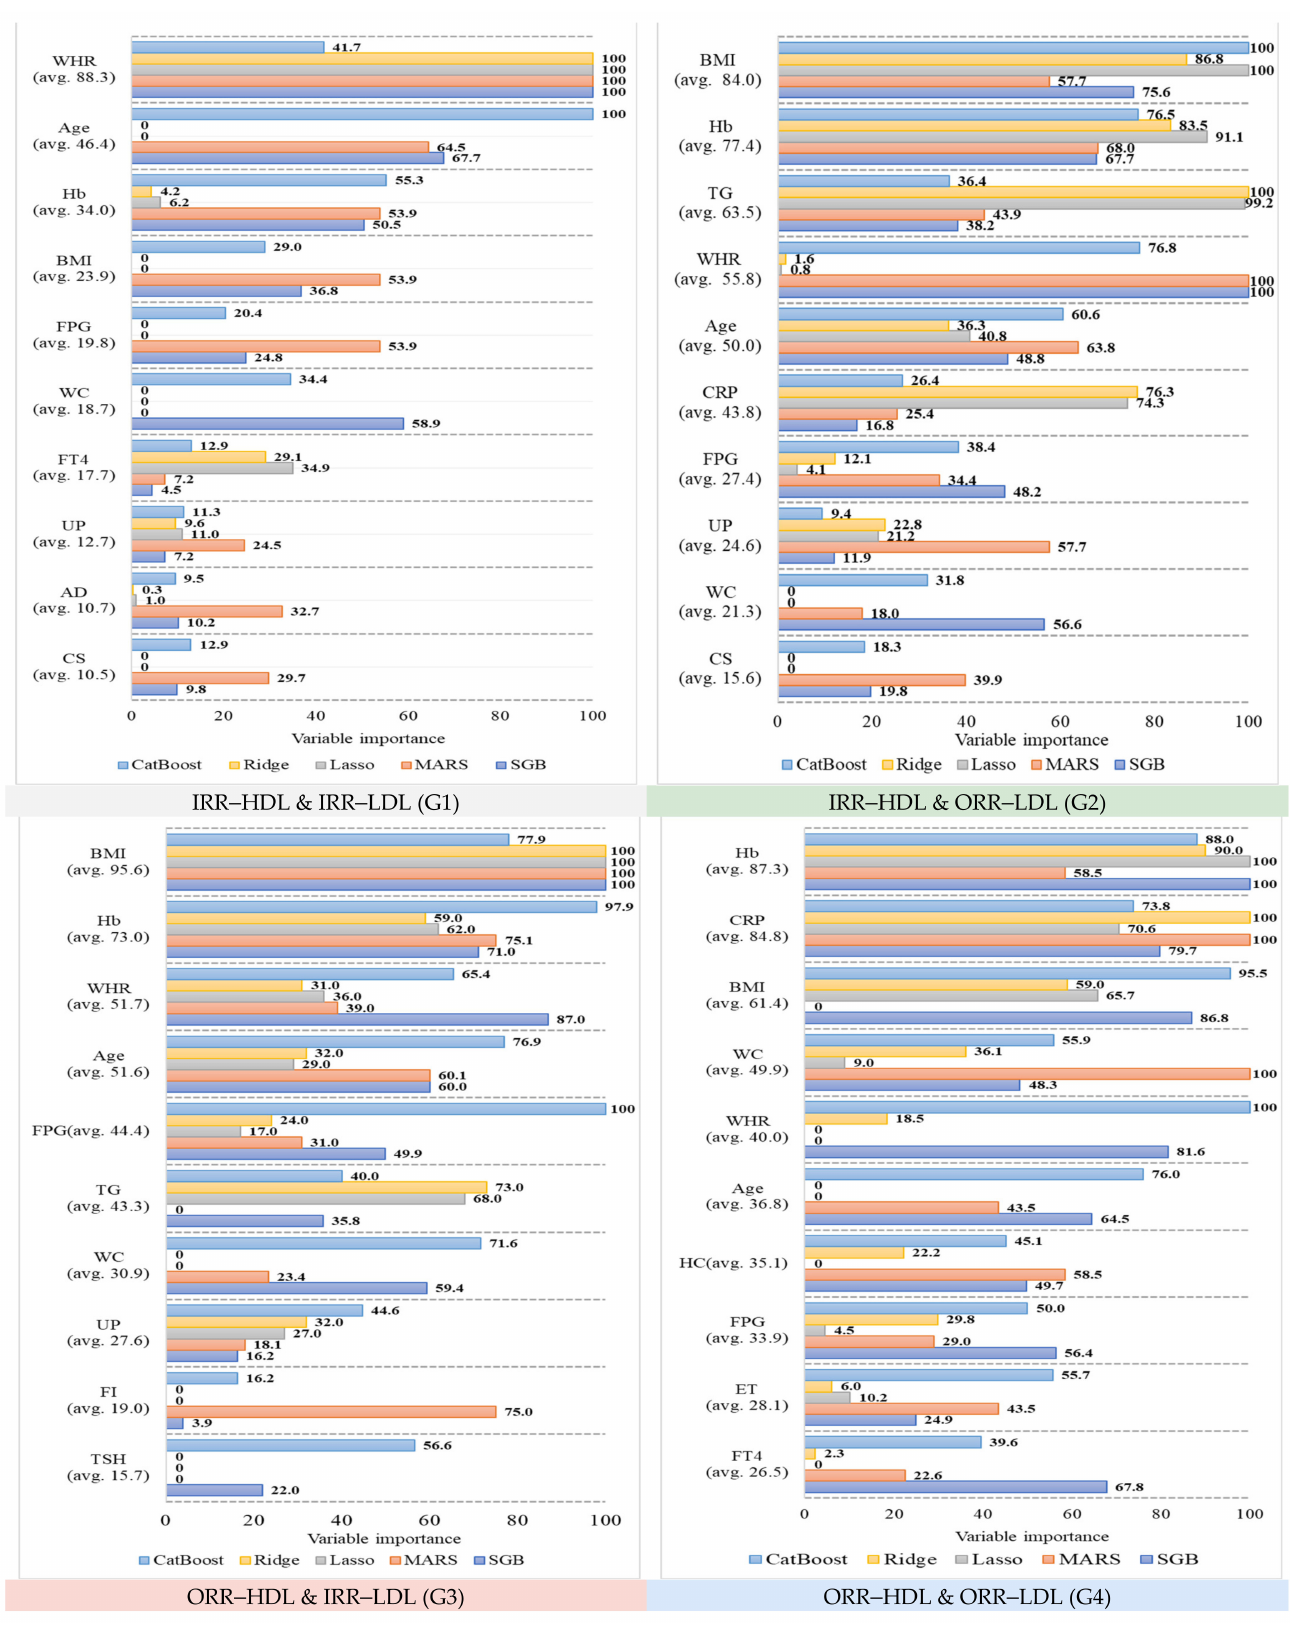
Figure 4. The variable importance generated by the generated by the five algorithms for each risk factor in the four